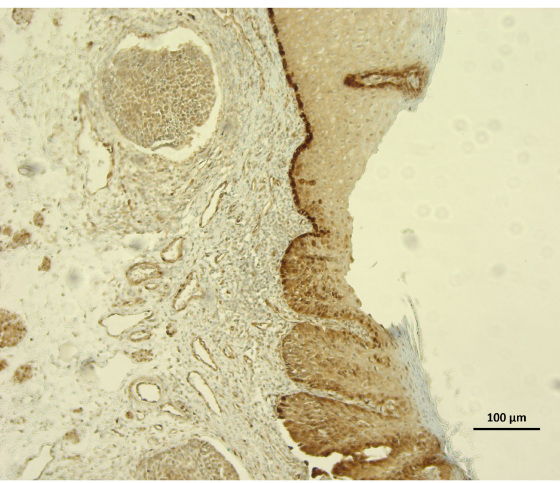
Figure 4. Full coat staining in high-grade epithelial dysplasia areas and only basal layer staining in the adjacent epithelium without dysplasia.